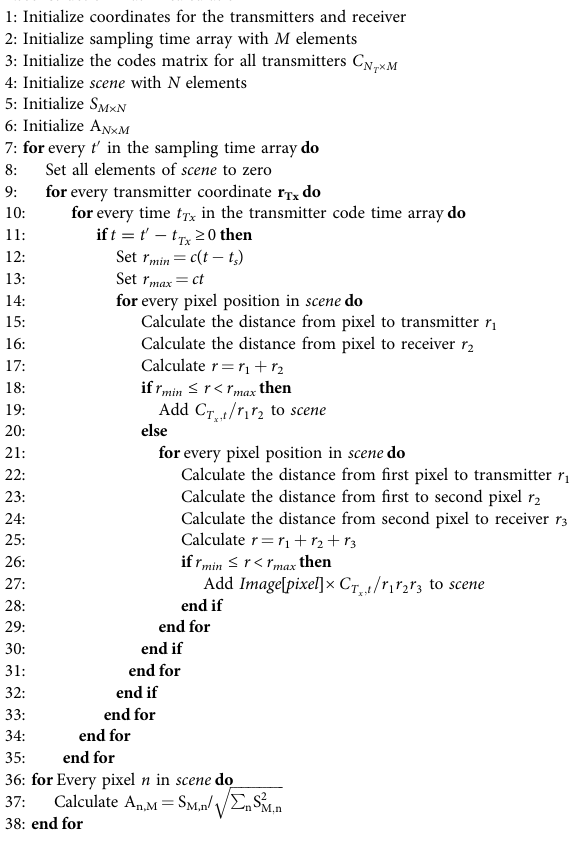
Reconstruction matrix calculation in 2D 1: Initialize coordinates for the transmitters and